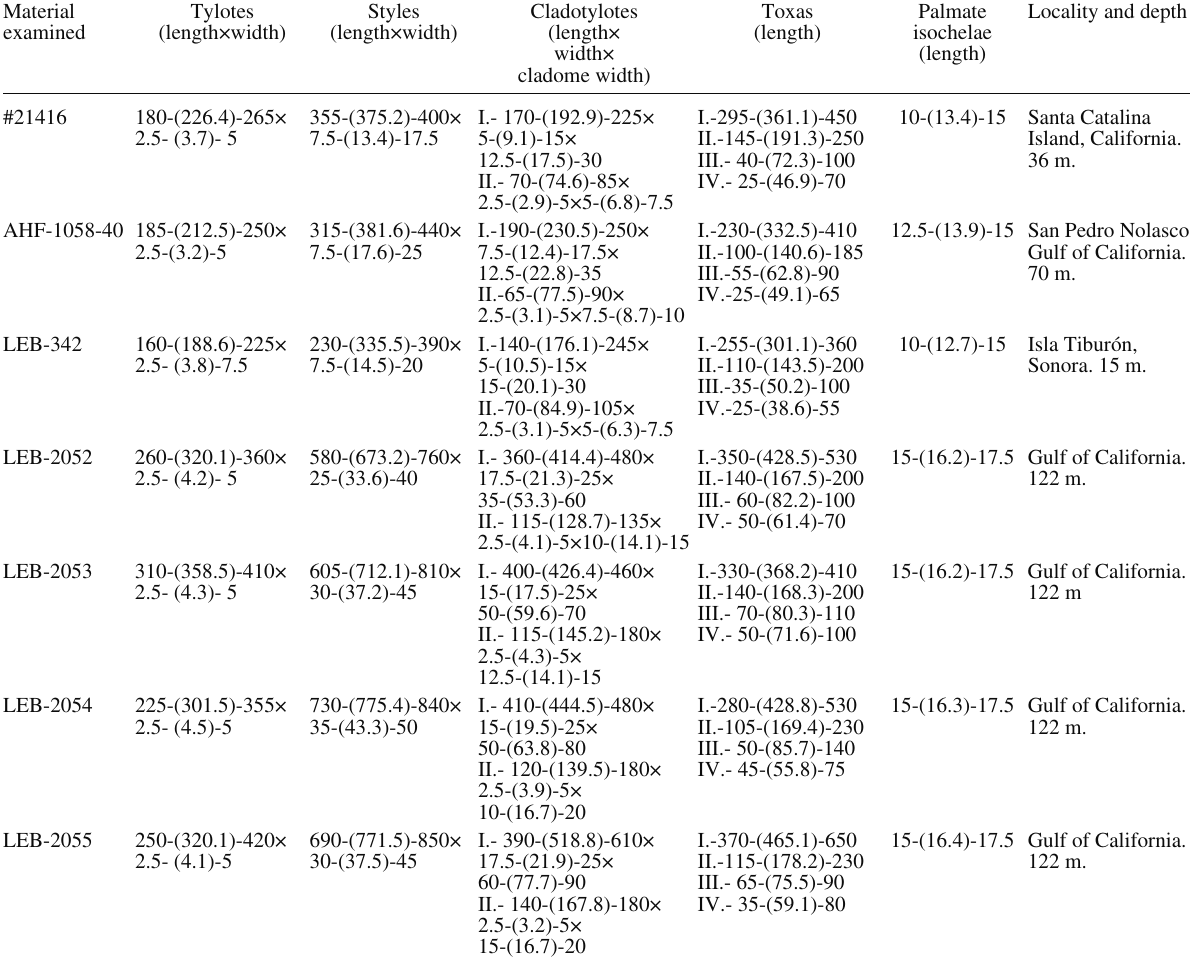
two categories: I, long, thick and smooth (180-610×5- 25 μm), cladome 12.5-90 μm (Fig. 2C); II, short and microspined (65-180×2.5-5 μm), cladome 5-20 μm (Fig. 2D). Toxas with a pronounced curvature in two categories: I, long and thick (230-650 μm). II, short and thin (100-250 μm) (Fig. 2E). Oxhorn toxas in two categories: I, thick (35-140 μm); II, thin (25-100 μm) (Fig. 2F). Palmate isochelae with the alae fused to the shaft (10-15 μm) (Fig. 2G). The ectosomal skeleton is a dense layer of tylotes (30-60 μm thick). The choano- somal skeleton is an isotropic reticulum of ascending multispicular fibres (80-250 μm thick), interconnected by secondary multispicular fibres (30-150 μm thick). The organization forms rectangular and quadrangular meshes (160-300 μm wide). Microscleres are dispersed with no special organization.